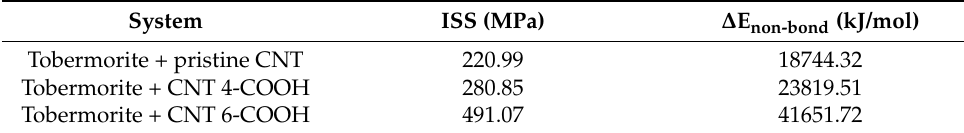
Table 4. ISS and non-bond energy.